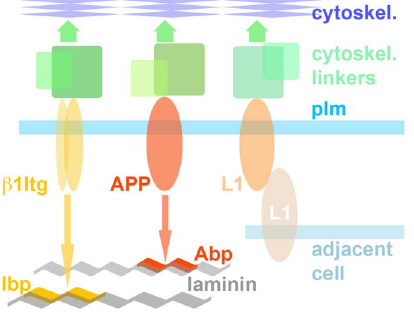
Figure 9. Schematic of GC-substrate interactions mediated by the three cell adhesion molecules of interest in this study. Itgb1 s and APP bind to distinct sequences on two different laminin subunits. Even though they can form complexes cell adhesion occurs independently, probably requiring distinct sets of cytoskeletal linker